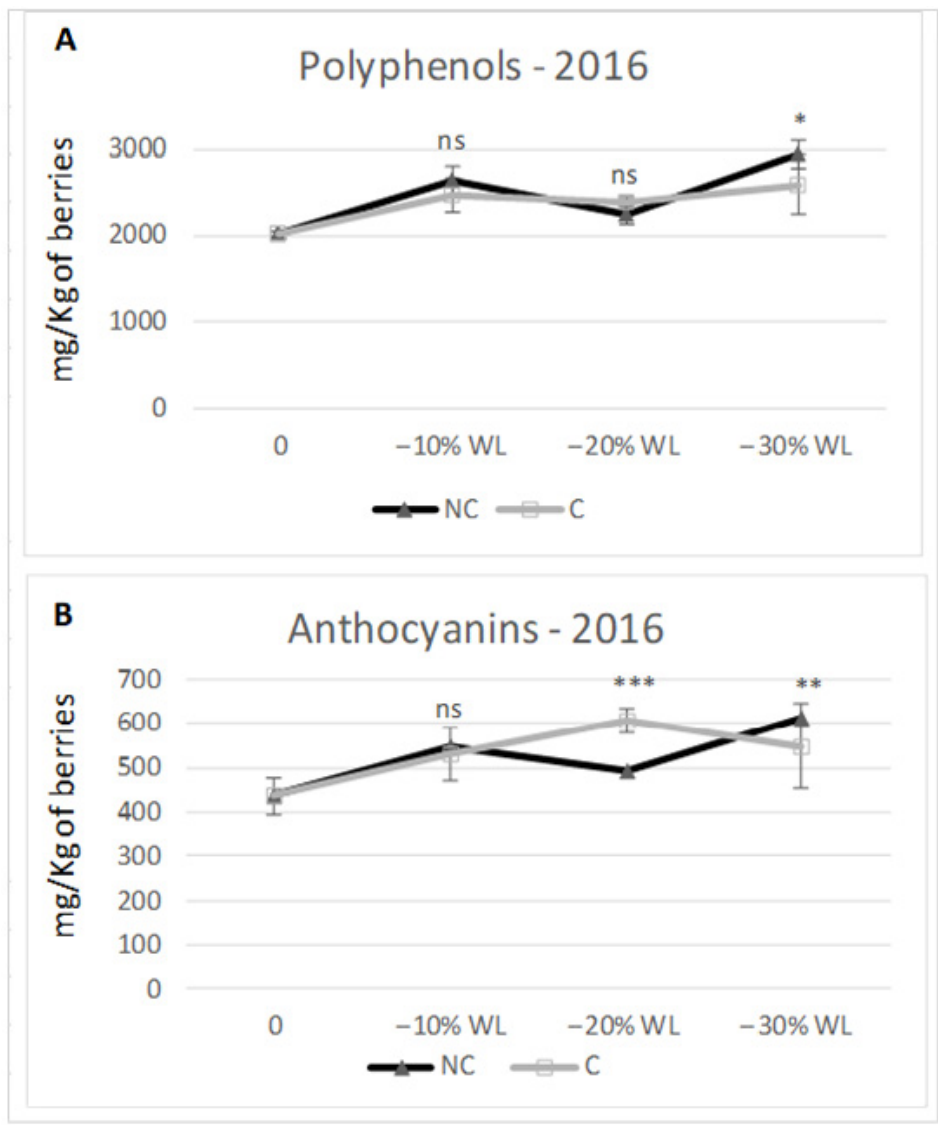
Figure 7. Content in polyphenols ( A ) and anthocyanins ( B ) in 2016. Data are the mean of three berry samples. *; **; *** indicate a significant difference ( p ≤ 0.05, 0.01, 0.001) between C and NC treatment. Vertical bars indicate standard deviation of 3 analytical replicates .